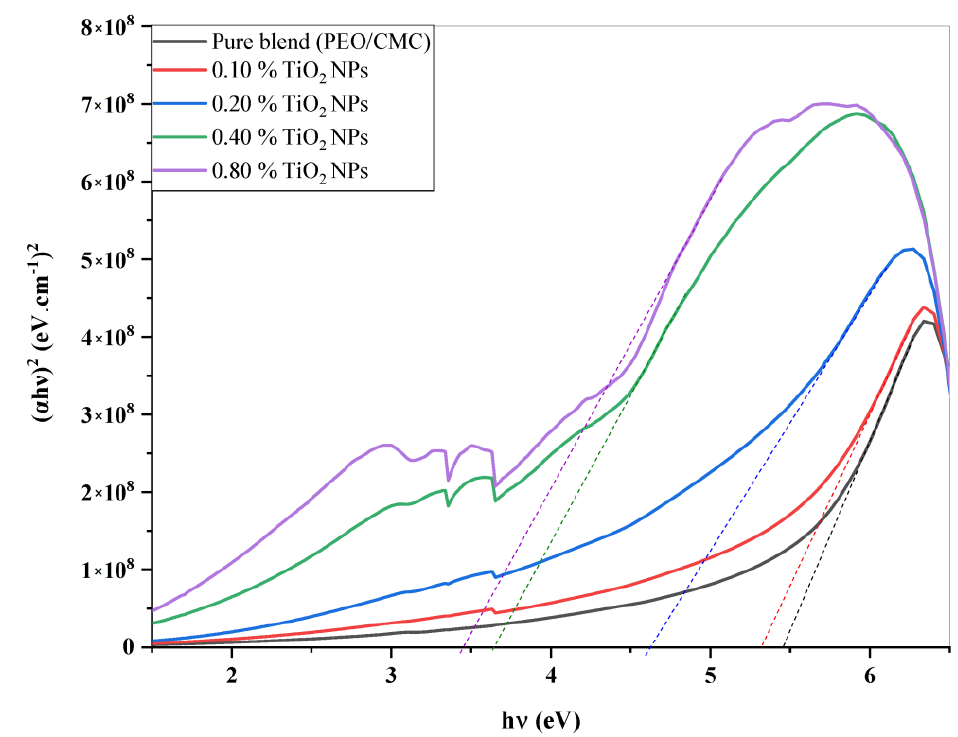
Figure 7. Plots of ( α h υ ) 2 vs. h υ of the PEO/CMC blend and the PEO/CMC filled with various amounts of TiO 2 NPs. Table 2. Optical energy gaps ( E gi and E gd ) and the absorption edge values for PEO/CMC/TiO 2 NPs samples. The Concentration of TiO 2 NPs (wt.